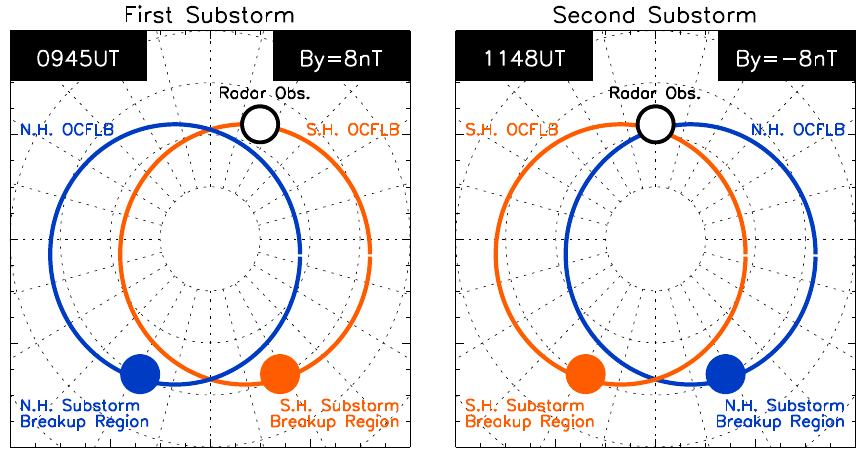
Fig. 6. A schematic diagram of the situation accounting for the difference in response time of the spectral width boundary to the substorm expansion at the time of the first substorm onset (left panel) and the second substorm onset (right panel). Magnetic local noon is toward the top of the